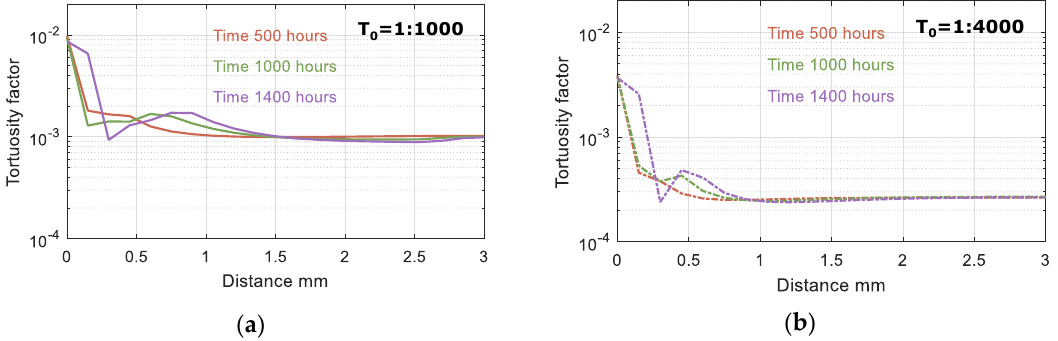
Figure 11. Tortuosity factor after 500, 1000 and 1400 h of exposure. Modeled results are shown for two values of the initial tortuosity factor (T 0 ): ( a ) T 0 = 1:1000 and ( b ) T 0 = 1:4000.